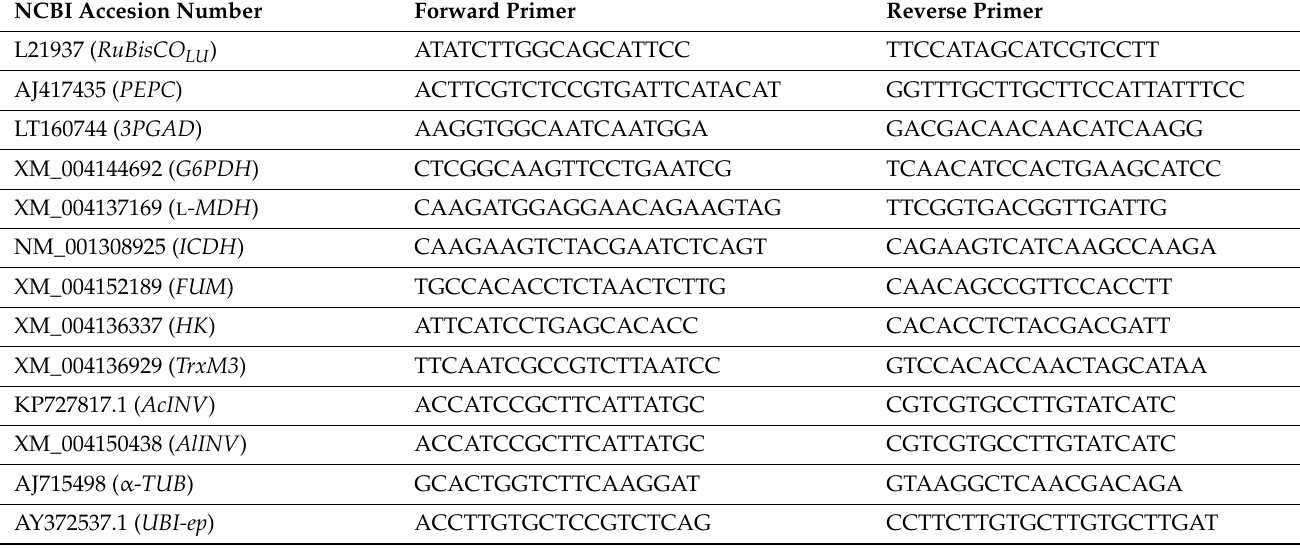
Table A2. Primer sequences for the target and reference